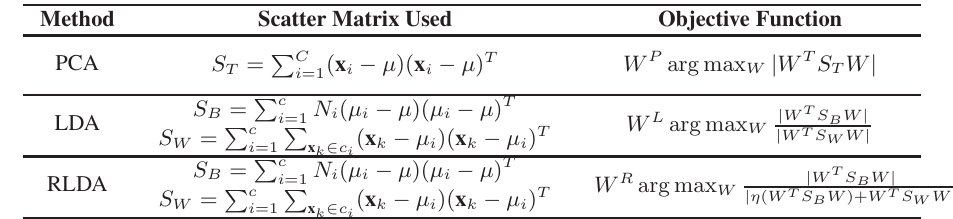
Table 1. Characteristics of PCA, LDA and regularized linear discriminant analysis (R-LDA).